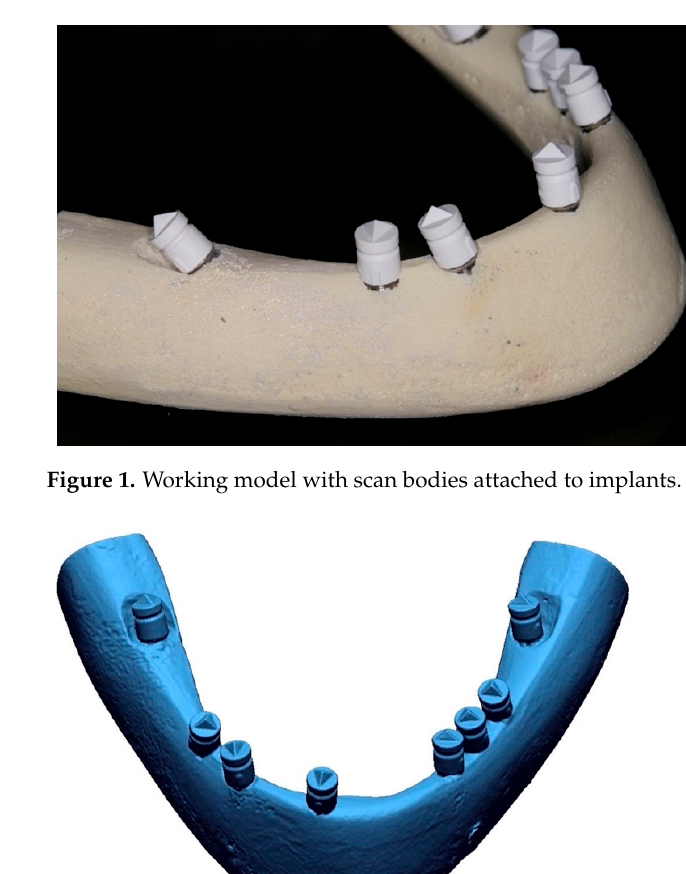
Figure 2. Reference 3D model obtained with optical scanner.